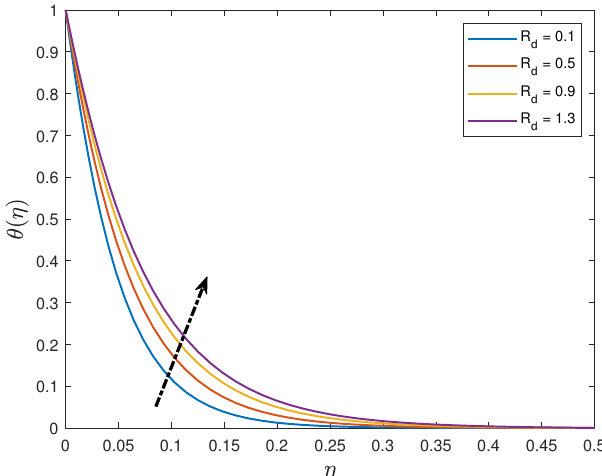
Figure 10. Influence of R d on the nanofluid temperature.